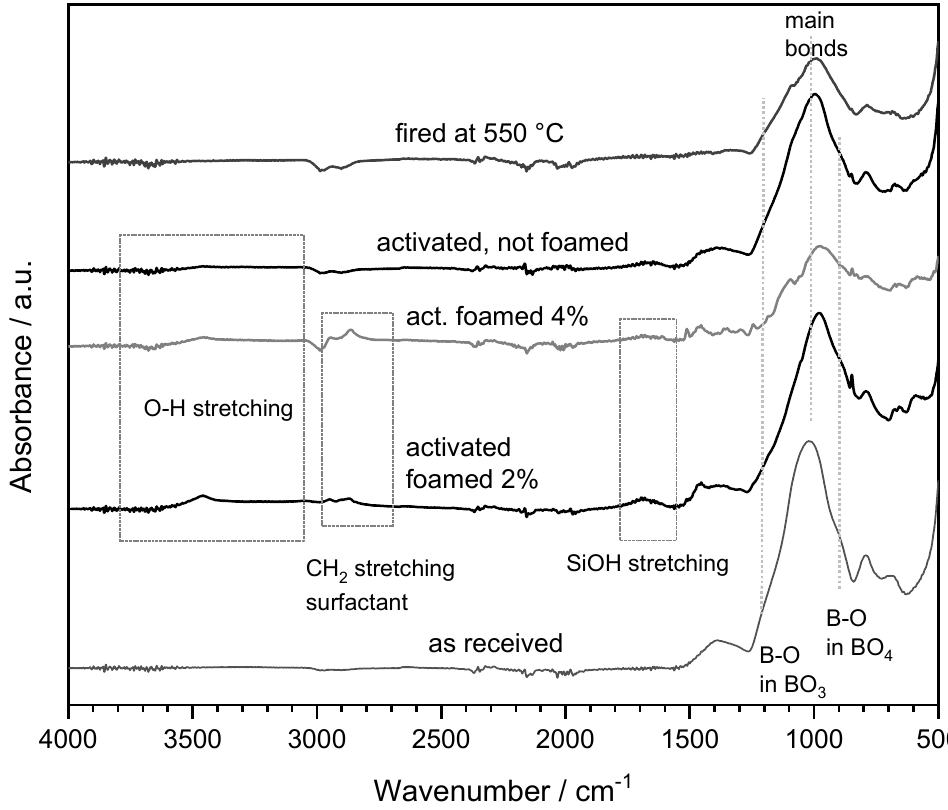
Figure 3. Fourier transform infrared (FTIR) analysis of boro − alumino-silicate glass in the as-received state, after activation and after firing.